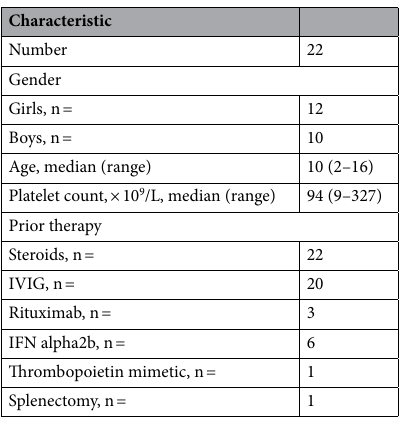
Table 2. Patient characteristics on